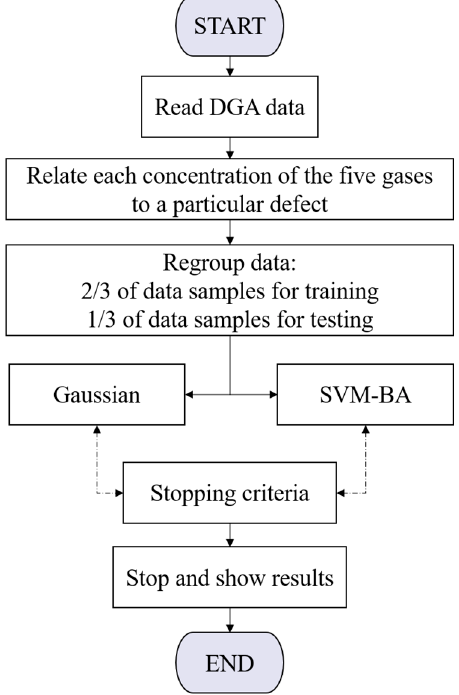
Figure 2. Flowchart of the problem formulation.